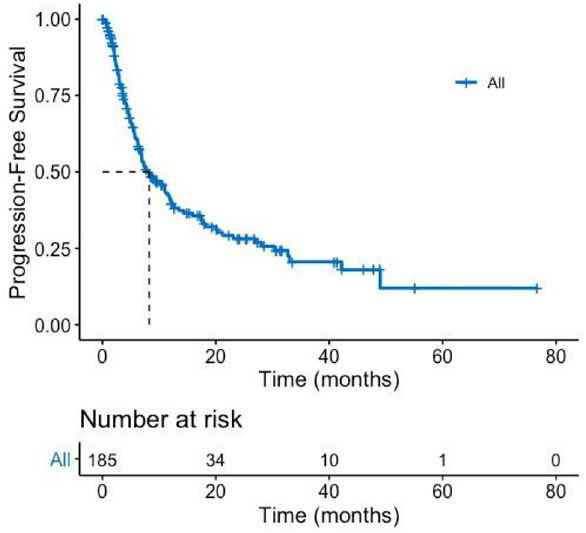
Figure 1. Kaplan-Meier estimates for progression-free